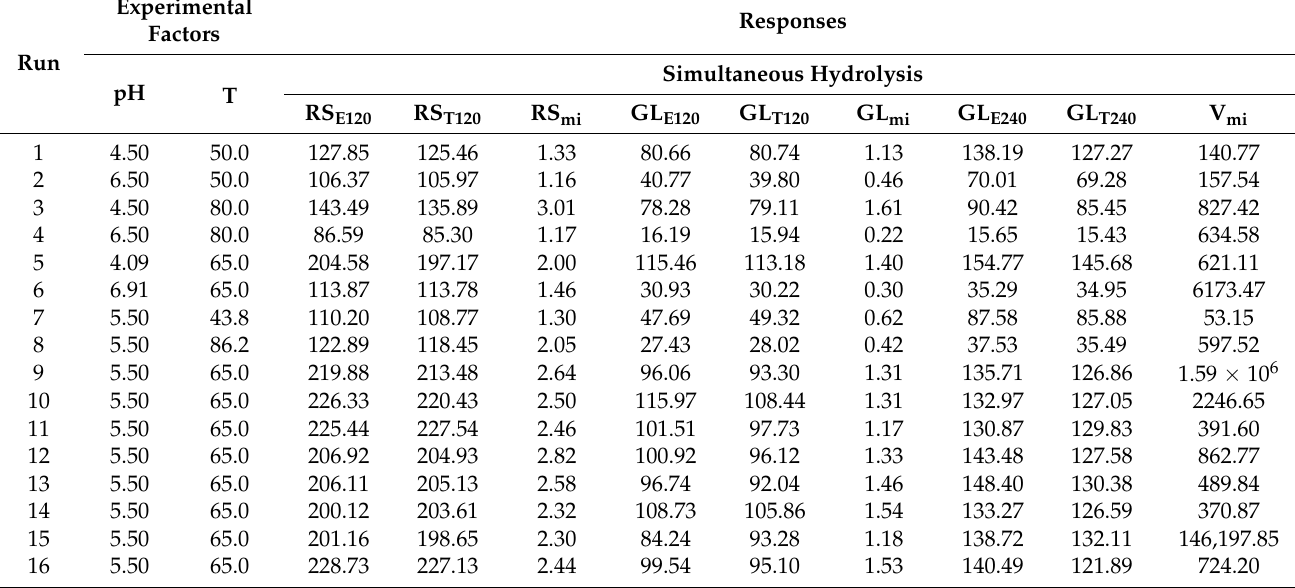
Table 2. Central composite design and responses for the study of pH and temperature in the simultaneous enzymatic